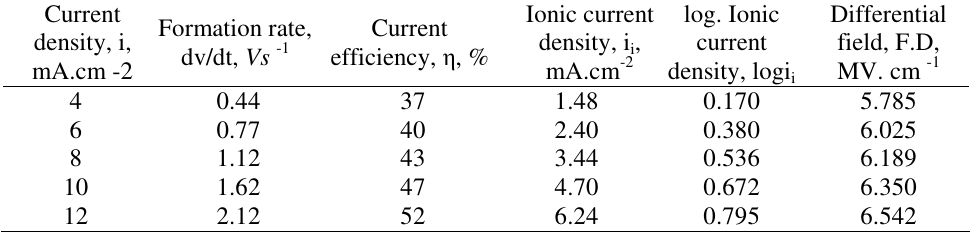
Table 4. Data on the anodization of Zr-2 in 0.1 M potassium malonate.